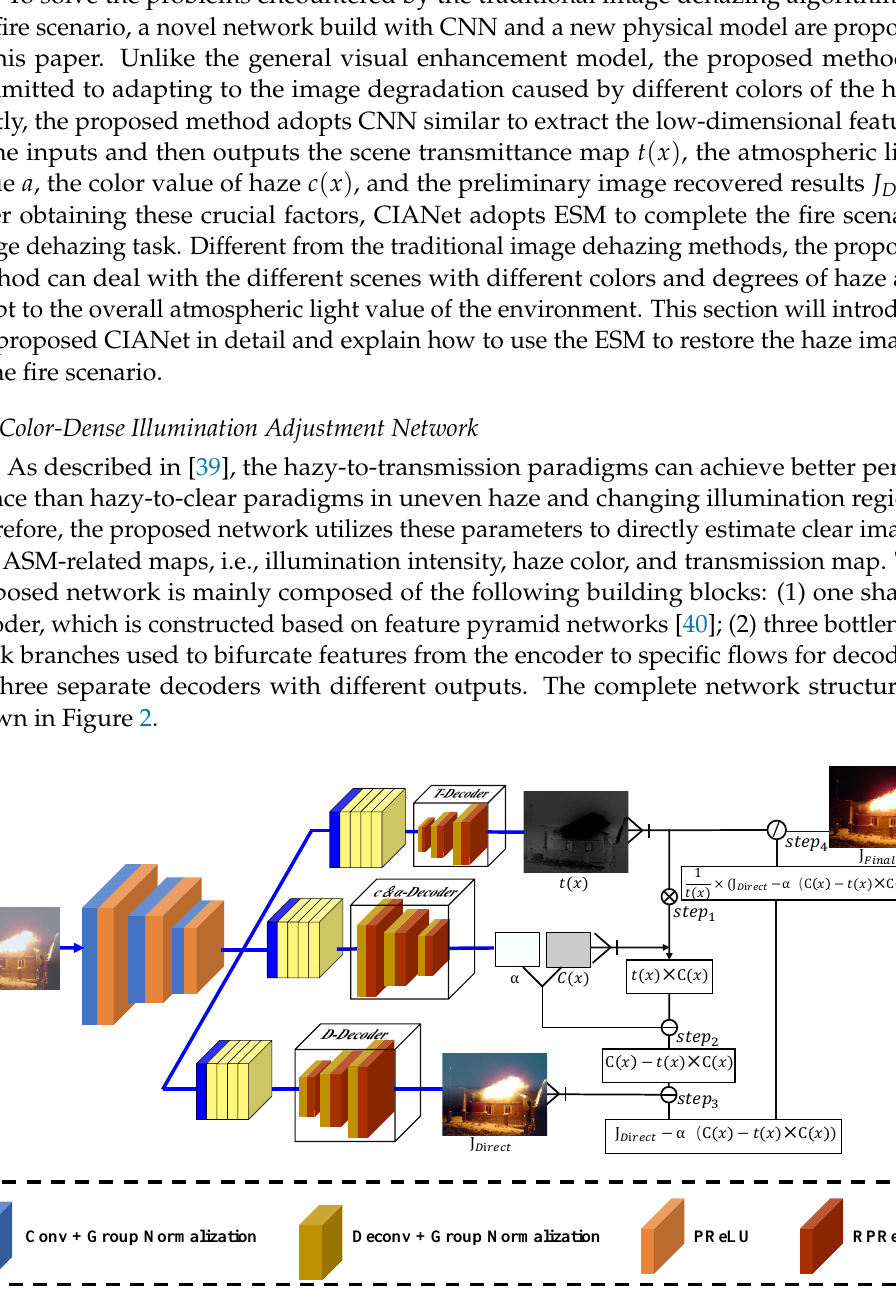
Figure 2. The structure of the proposed CIANet. All decoders are identical except for the c & α decoder , which outputs two floating point numbers The T-decoder and D-decoder outputs